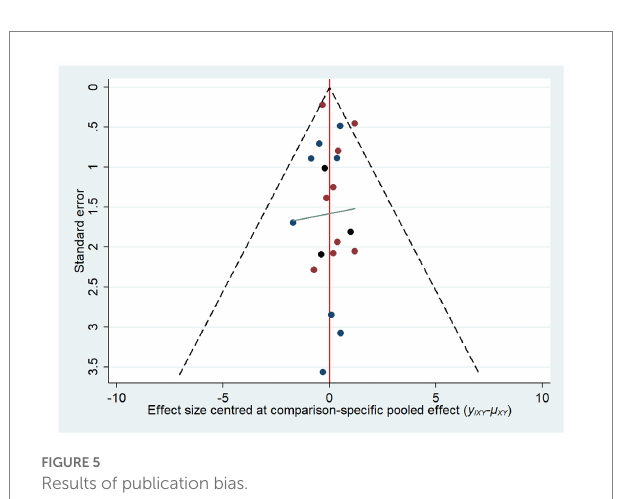
FIGURE 5 Results of publication